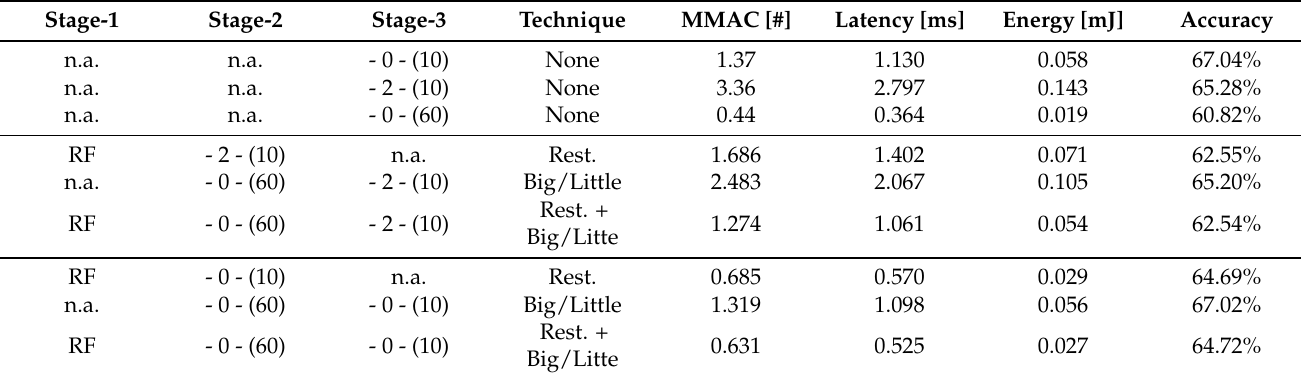
Table 3. Performance of dynamic inference solutions on